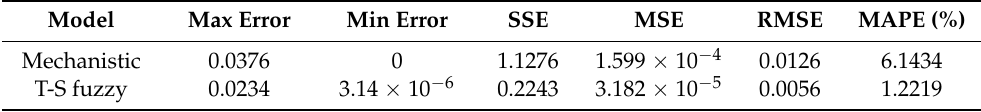
Figure 15. Modeling results under pumping convert to power generation condition. ( a ) Rotation speed curves comparisons; ( b ) Rotation speed errors of two models. Table 5. Performance indexes under pumping convert to power generation